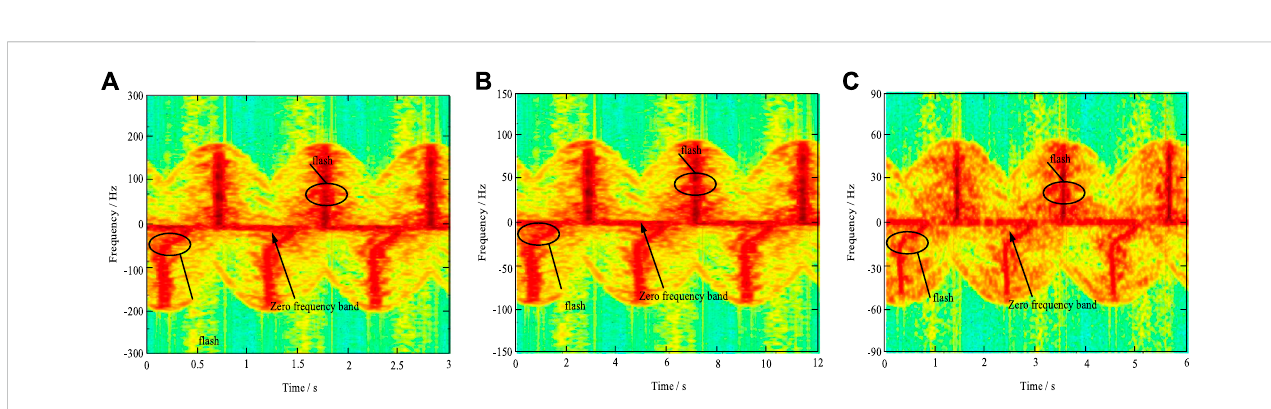
FIGURE 8 Comparison of time-frequency echoes of blades at a different speed. (A) Time-frequency domain of echoes with a frequency of 1 GHz and the speed of π /3 rad/s, (B) Time-frequency domain of echoes with a frequency of 1 GHz and the speed of π /6 rad/s, (C) Time-frequency domain of echoes with a frequency of 1 GHz and the speed of π /12